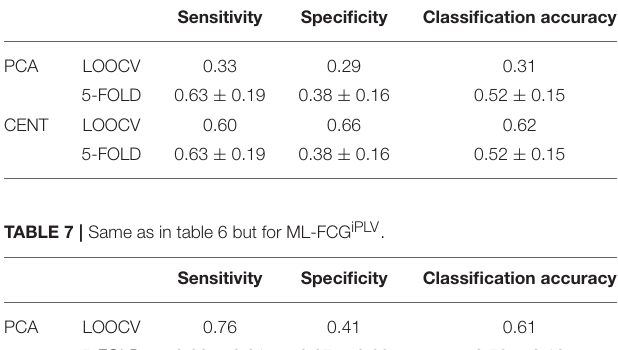
TABLE 6 | Sensitivity, specificity and classification performance of MPL estimated over the ML-FCG CorrEnv using two ROI representation and two cross-validation schemes.